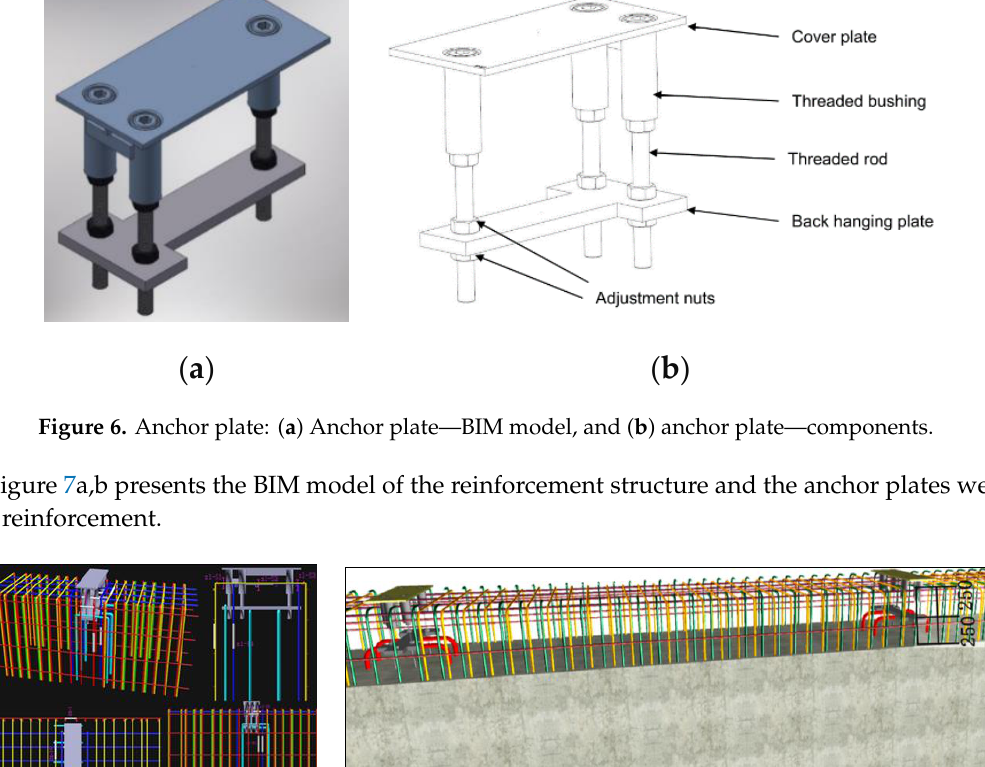
Figure 5. Building information modeling (BIM) model of the removable floodwall components.